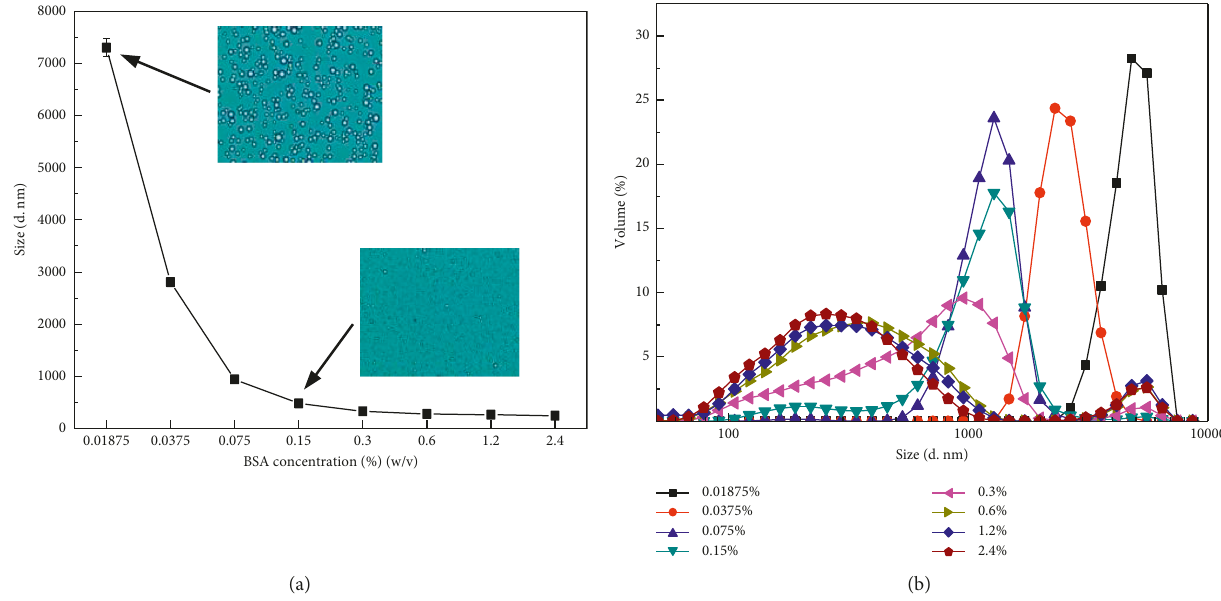
Figure 1: Influence of BSA concentration on mean particle diameter (a) and droplet size distribution (b) of emulsions (5% v/v oil, pH 7.0).